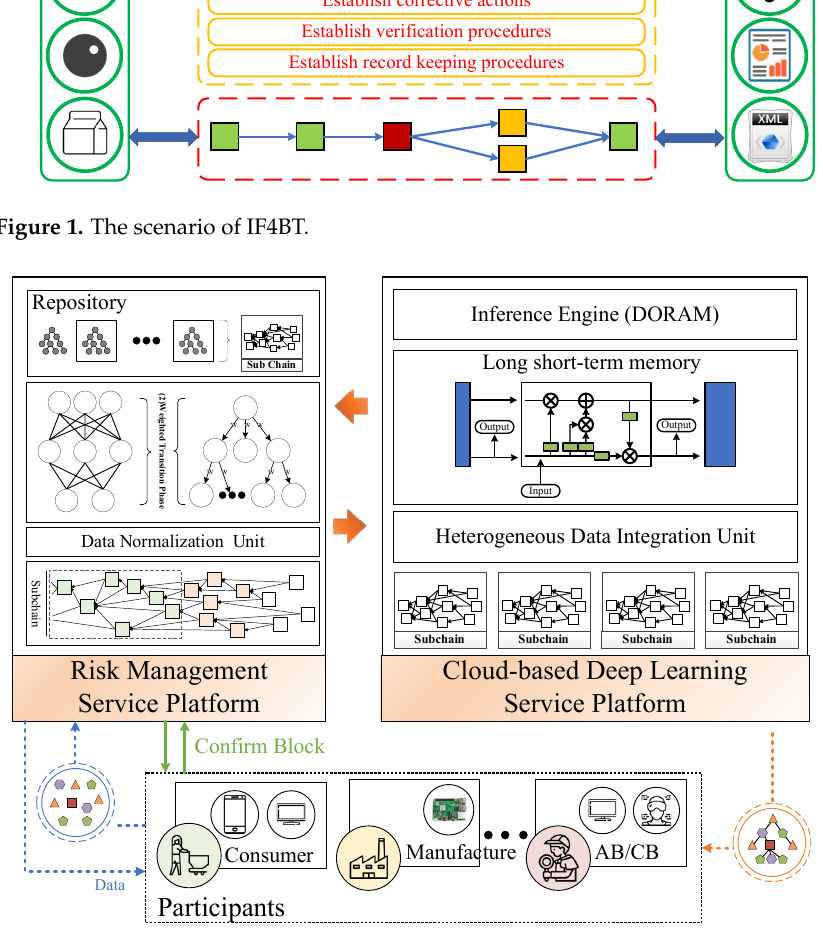
Figure 2. IF4BT framework.